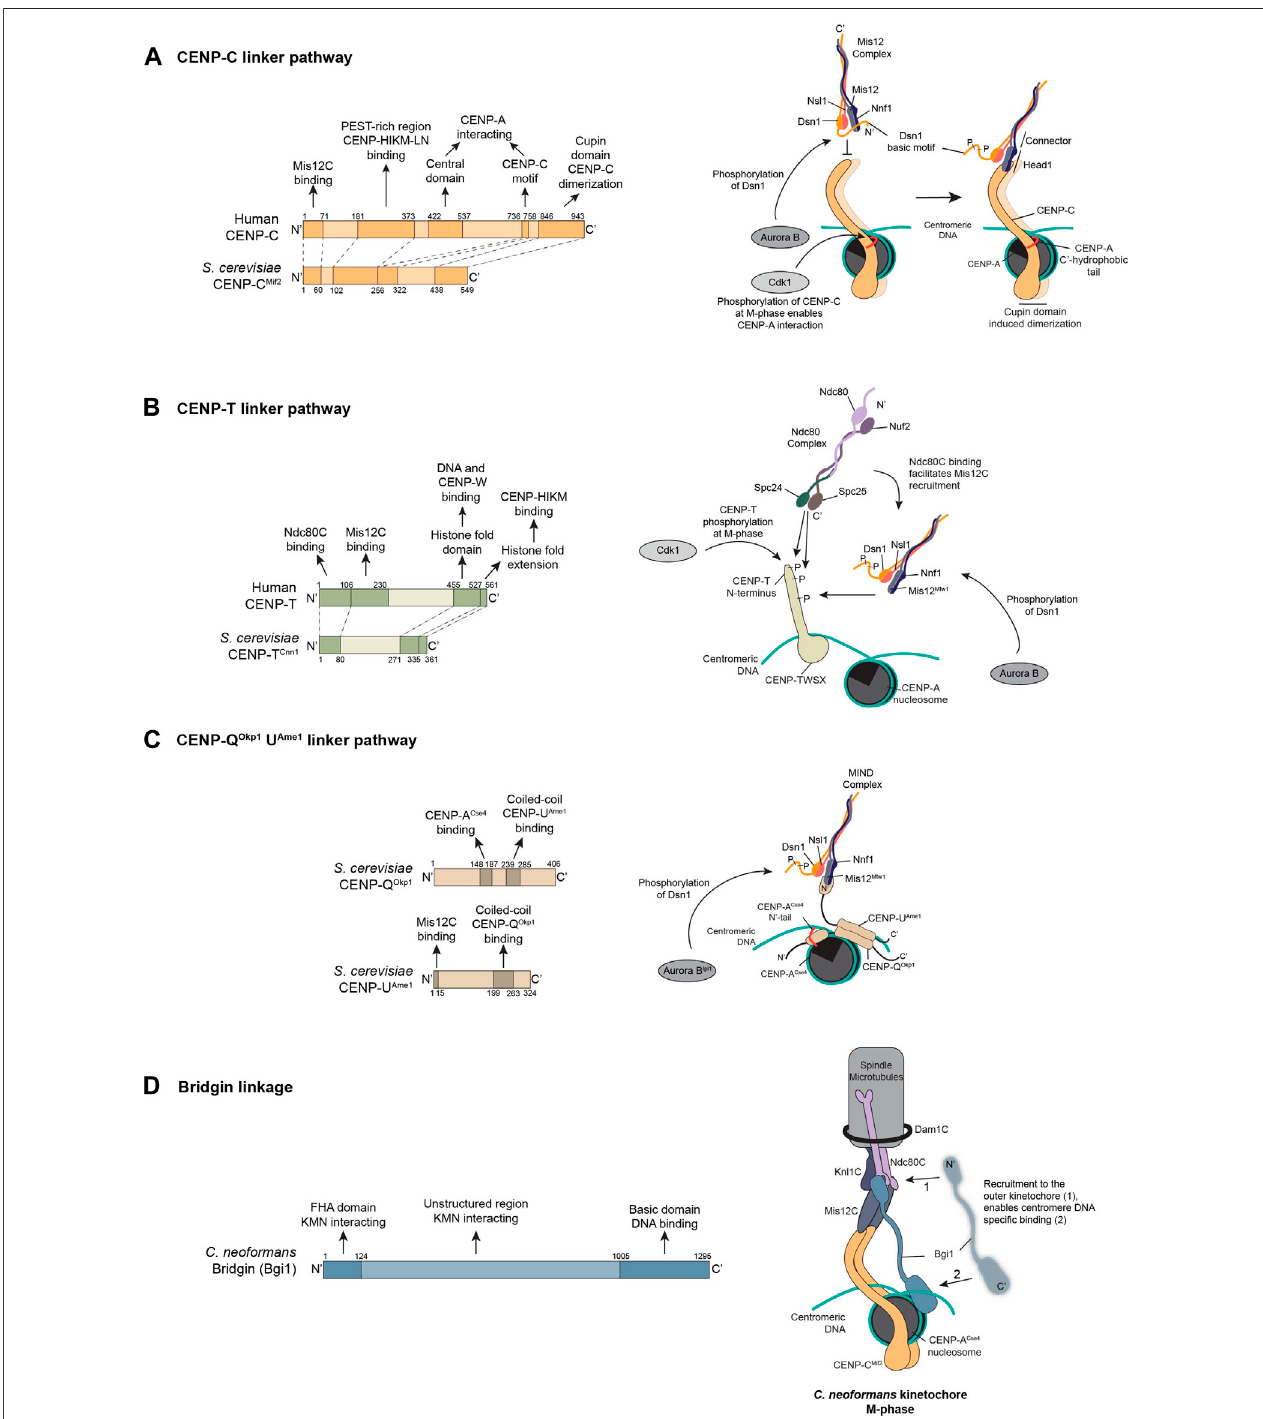
FIGURE2| Linkerpathwaysconnecttheouterkinetochoretocentromericchromatin. (A) TheCENP-ClinkerpathwayoriginatesthroughtheinteractionsofCENP- CwiththeC-terminalhydrophobictailofCENP-Aattheinnerkinetochore.Subsequently,CENP-CthroughitsN-terminalmotifinteractswiththeMis12-Nnf1headofthe Mis12C.Thisinteractionisweakened/inhibitedbytheDsn1basicmotifthatbindstoMis12anddiminishesinteractionwithCENP-Cinitsunphosphorylatedform.Aurora B-dependentphosphorylationalleviatesthisautoinhibition. (B) CENP-TcomplexinteractswithcentromericlinkerDNAthroughanucleosome-likestructureformed by the histone-fold domains of CENP-T-W-S-X. At the N-terminus, in the human CENP-T, two Ndc80C recruitment sites exist which is under the control of Cdk1 phosphorylation. This Ndc80C binding subsequently facilitates the recruitment of the Mis12C. The phosphorylated form of Mis12C by Aurora B preferentially binds to